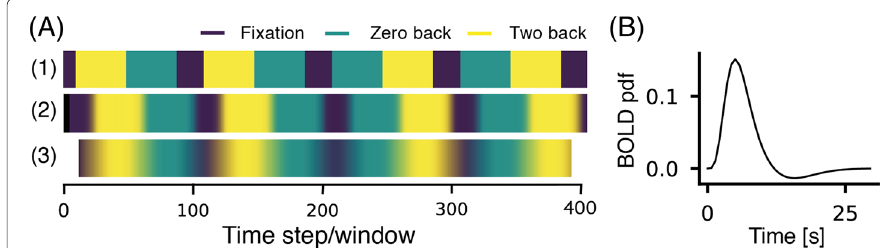
Fig. 1 Experimental design. a Schematic illustration of the order in which subjects undertake memory tasks during the experiment. We apply the same smoothing procedure to this illustration and the data. (1) The initial order of tasks and fixation (405 ticks). (2) The fMRI method measures blood oxidation rather than the actual neural activity, which offsets the measurement. To offset the sequence by the same amount we convolve it with the hemodynamic response function (Glover 1999) (see ( b )). (3) We apply a mean filter of width w = 25 across the sequence. The final sequence is of length 381